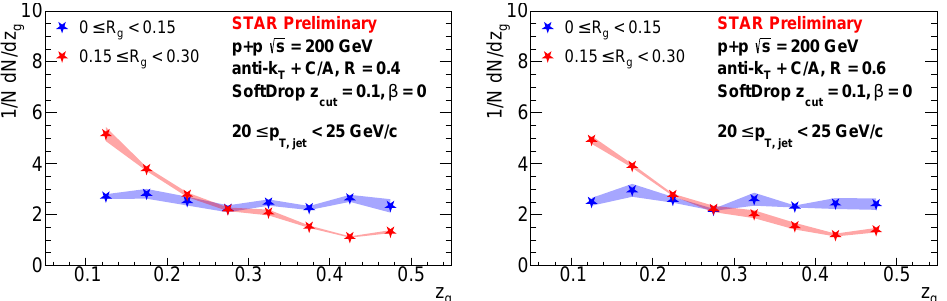
Figure 2: Fully unfolded z distributions for three R (cid:112) g s = 200 GeV. Individual panels correspond to different p collisions at (see legend).